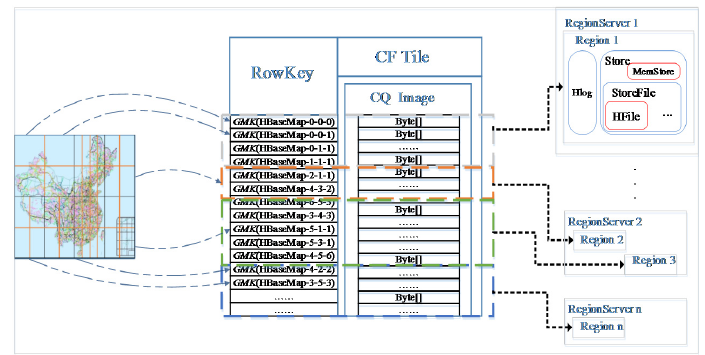
Figure 8. Distribution of map tiles in a NoSQL cluster.